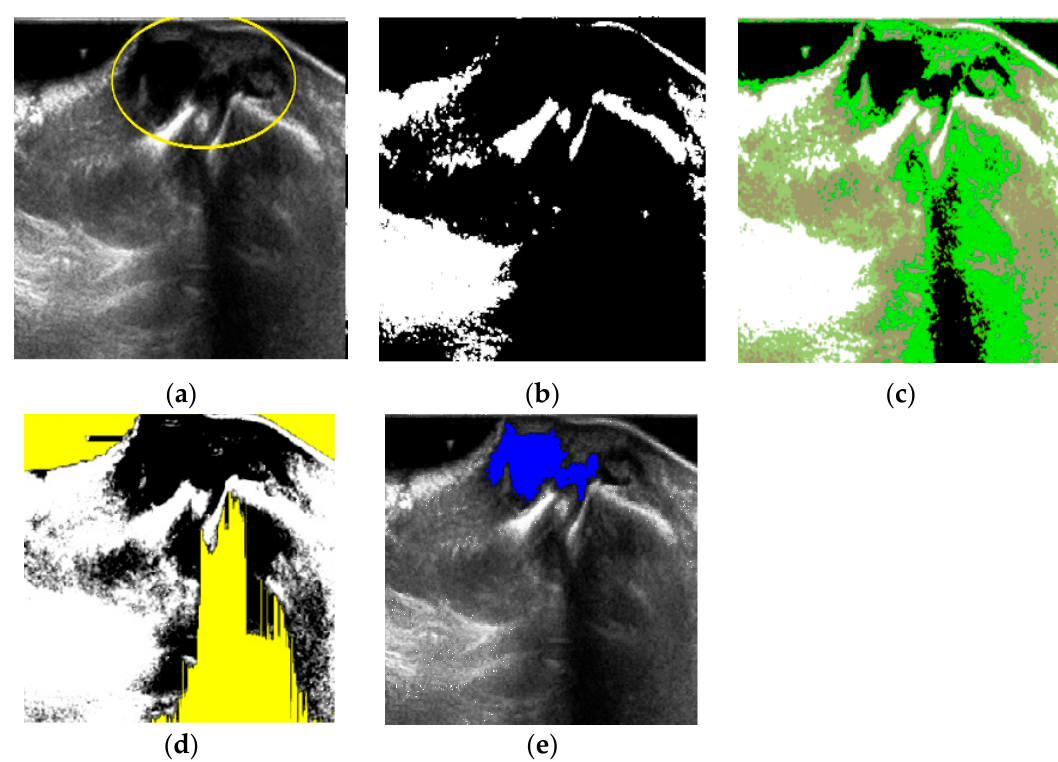
Figure 6. Ganglion cyst extraction process. ( a ) Input image 1; ( b ) Cluster =1 after DBSCAN; ( c ) FCM quantification; ( d ) noise by fuzzy stretching; ( e ) extraction by labeling.